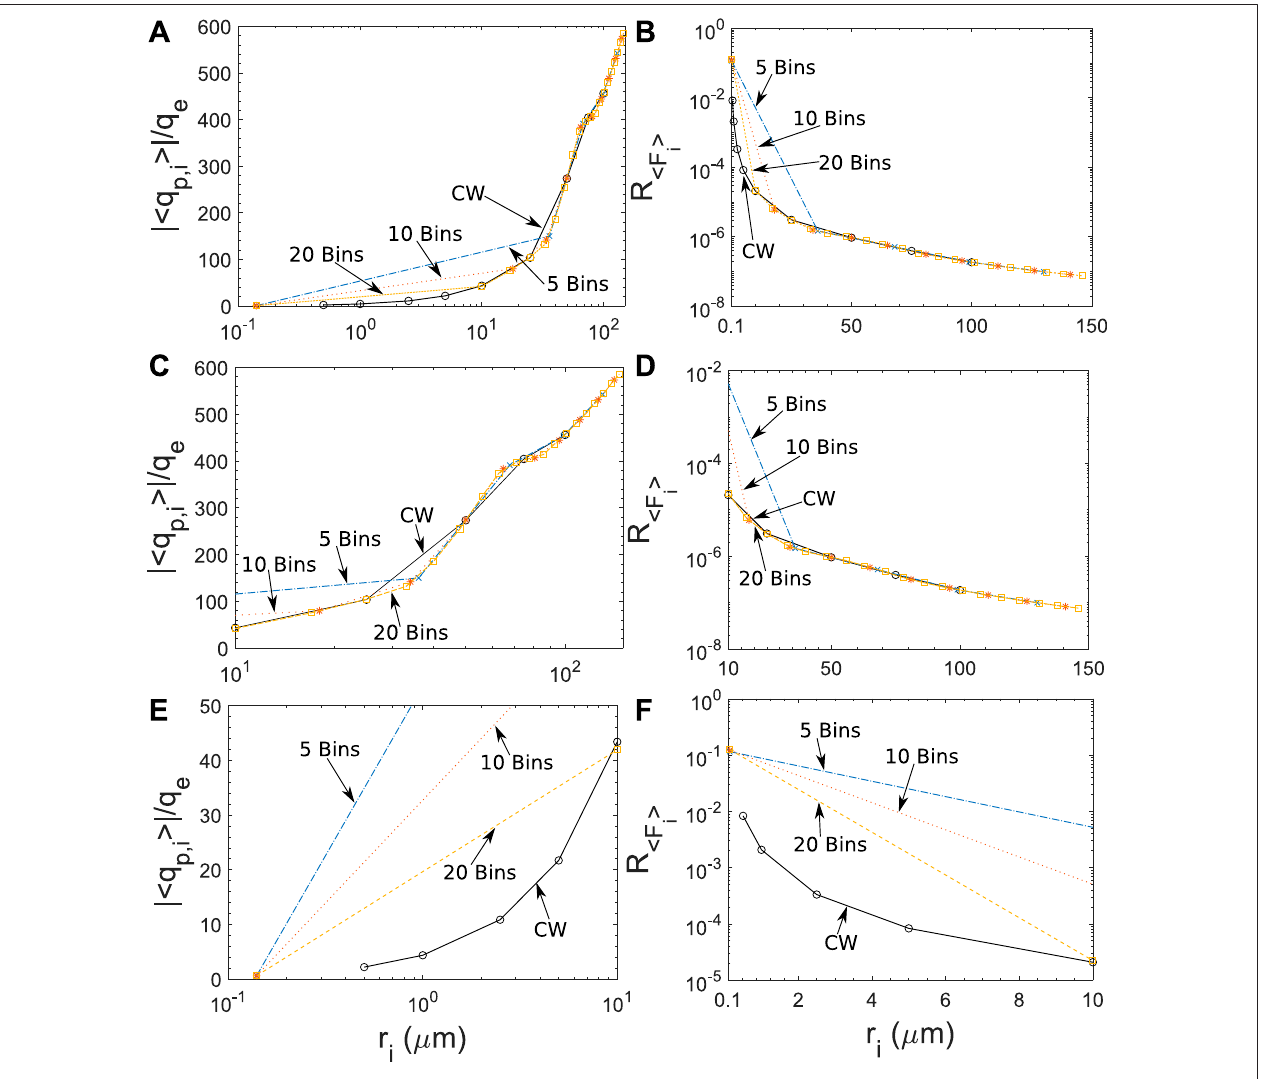
FIGURE 12 | Study on the proper discretization of the size distribution: (A) Number of elementary charges per particle as a function of particle radius for different types of binnings, (B) ratio between the electrical force magnitude and the gravity magnitude as a function of particle radius for different types of binnings, (C,D) magni fi cation of panels (A) and (B) for particle radius in the range of 10 − 150 μ m, (E,F) magni fi cation of panels (A) and (B) for particle radius in the range of 0.1 − 10 μ m.